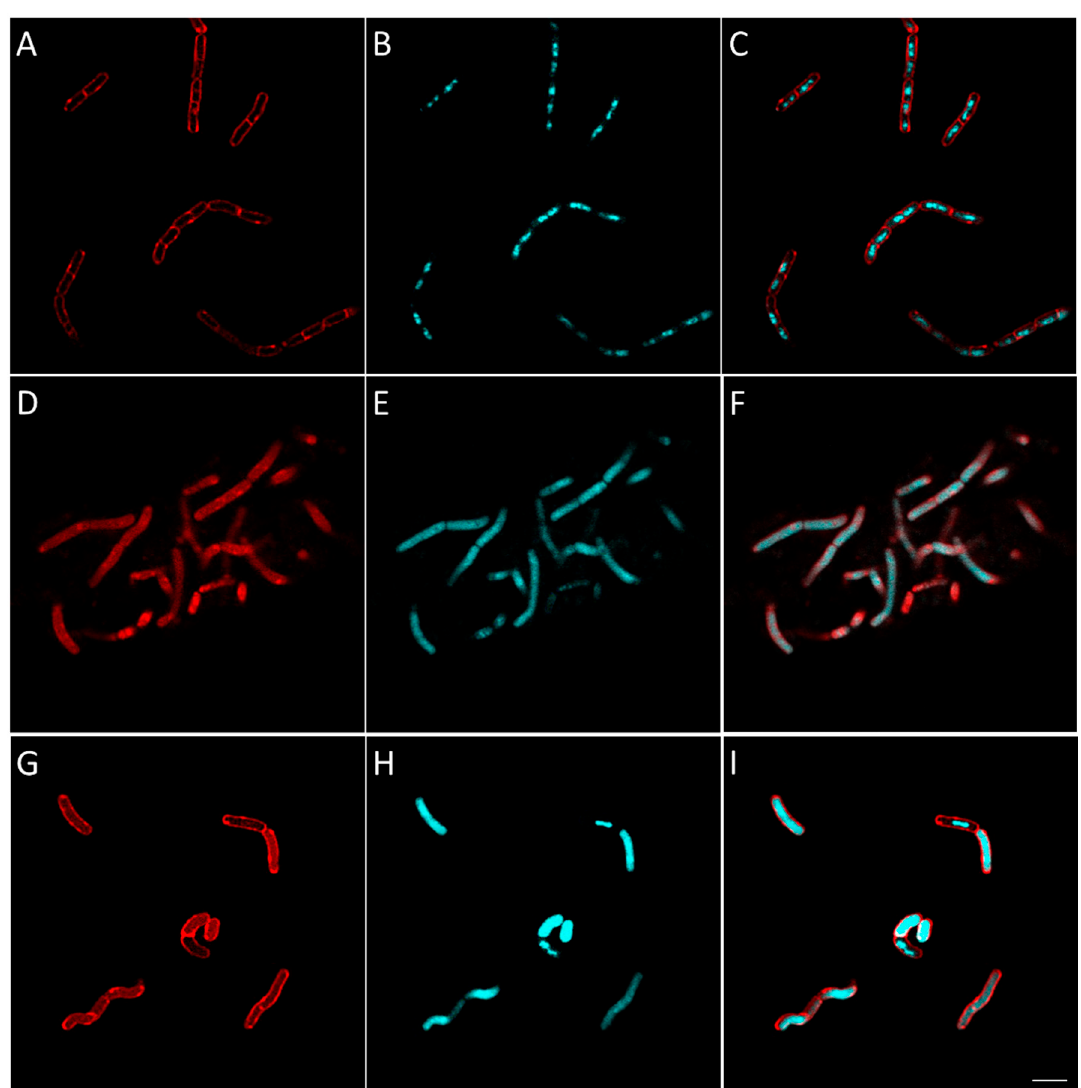
Figure 11. Morphological bacterial changes caused by compound 16 in V. alginolyticus . Morphological changes of V. alginolyticus caused by compound 16 were studied as explained in the Materials and Methods section. V. alginolyticus was incubated for 2 h at 37 °C in aerobic conditions with 4 X MIC of 16 ( D – F ). Control ( A – C ) was bacteria with no antibiotics added. At the end of the incubation, bacteria were fixed and membrane ( A , D , G ) and DNA ( B , E , H ) were stained using FM4-64FX (red signal) and DAPI (blue signal), respectively. Membrane and DNA signals were merged in the figure in ( C , F , I ). The effect of amoxicillin, an inhibitor cell wall synthesis, is shown for comparison in ( G – I ). Bacteria were observed using confocal microscope and images representative of observed effect were taken. The white scale bar on the bottom right corner corresponds to 4 µm.